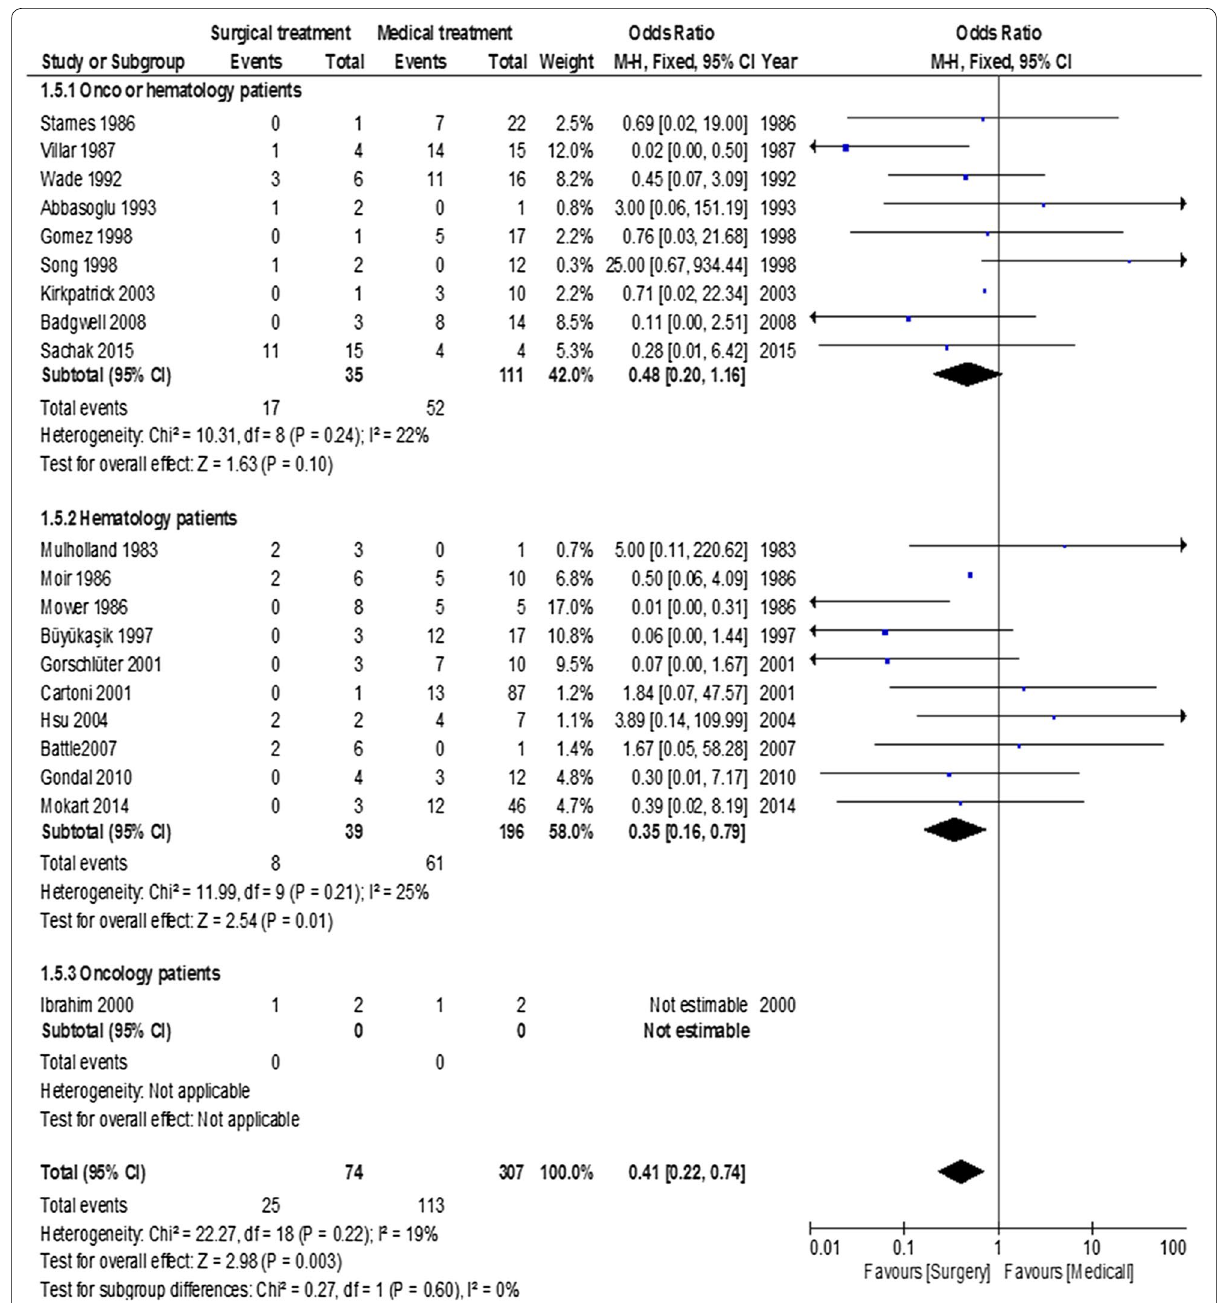
Fig. 5 Summary of odds ratio in included studies according to underlying